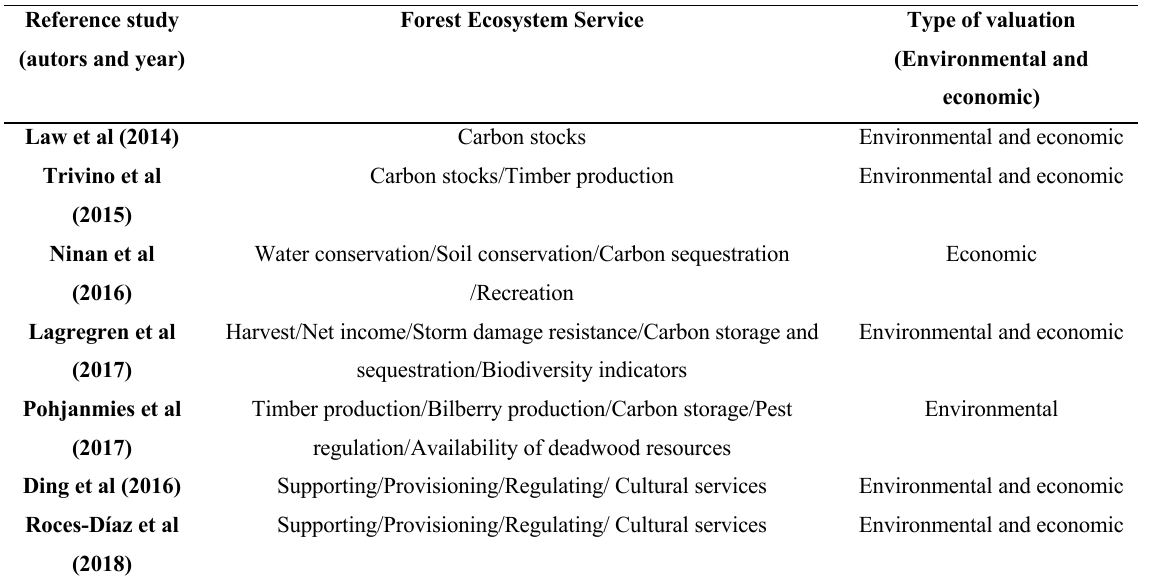
Table 1: Summary of studied researches, the assessed ES and the type of